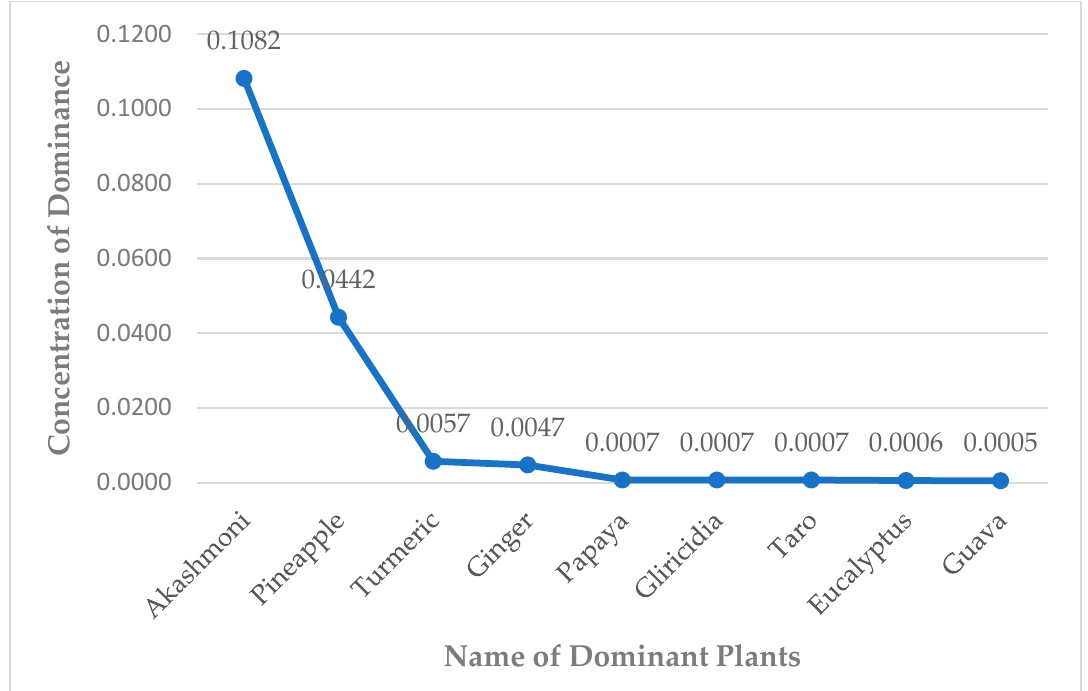
Figure 6. Concentration of Dominance of the dominant plant species in Madhupur.